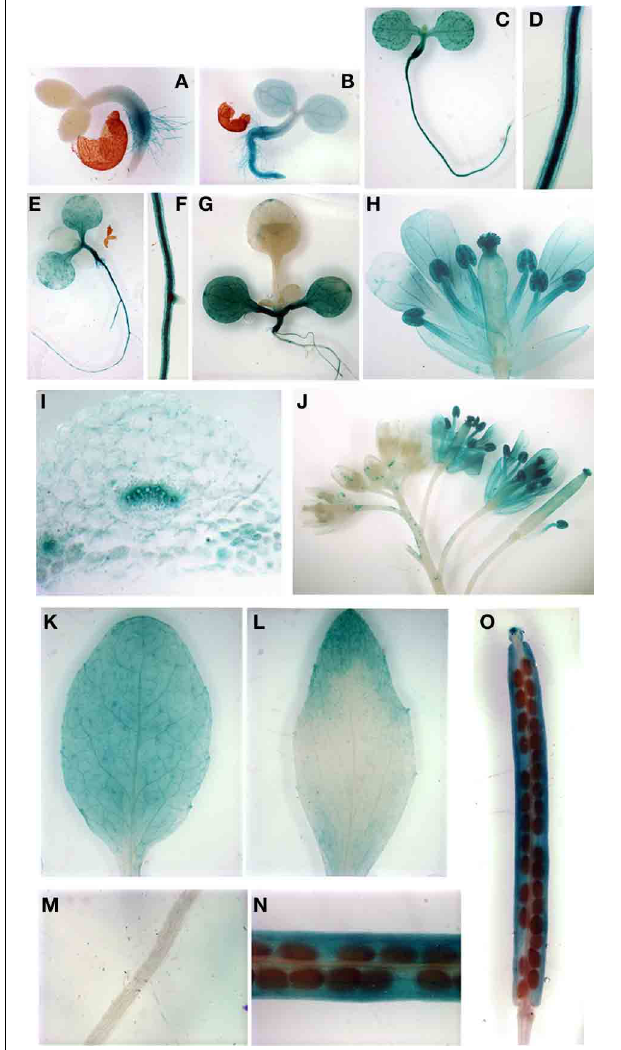
FIGURE 2 | Histochemical staining of AtYSL4 promoter-GUS reporter plants. (A) Seedling at 48h (B) Seedling at 72h (C) Seedling at 5 days (D) Root of 5-day-old seedling (E) Seedling at 8 days (F) Root of 8-day-old seedling (G) Seedling at 11 days (H) Flower at 36 days (I) Cross-section of rosette leaf at 36 days (J) Flowers at 36 days illustrating mature and immature flowers (K) Rosette leaf at 37 days (L) Cauline leaf at 37 days (M) Root at 24 days (N,O) Siliques at 24